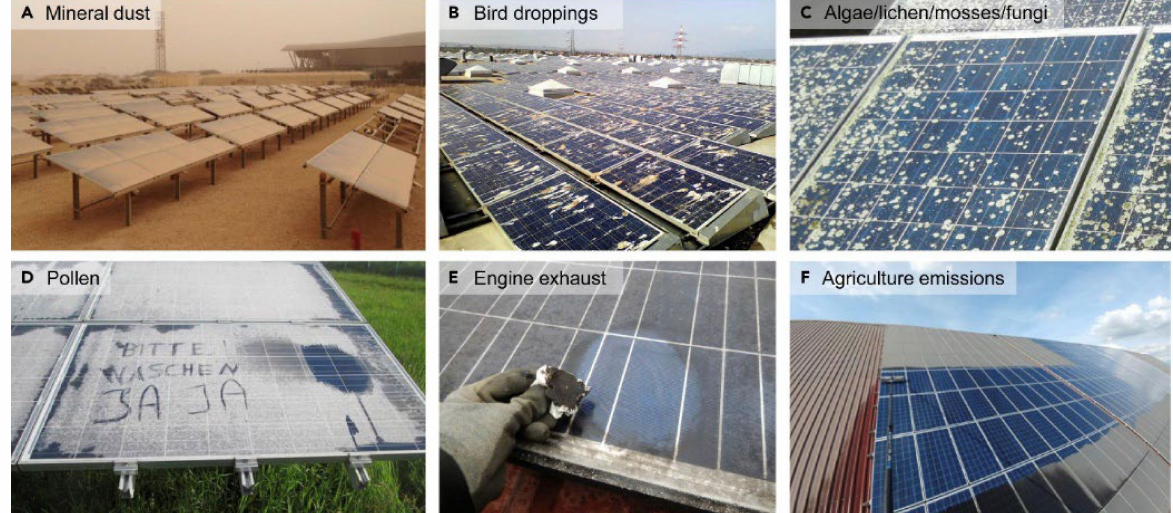
Figure 3. Examples of soiling: Overview of different soiling types with exemplary photographs of soiling by ( A ) mineral dust in a desert area, ( B ) bird droppings, ( C ) algae, lichen, mosses, or fungi and ( D ) pollen in wet and moderate climates, ( E ) engine exhaust from an industrial area, and ( F ) agricultural emissions. Reproduced with permission from Ref.